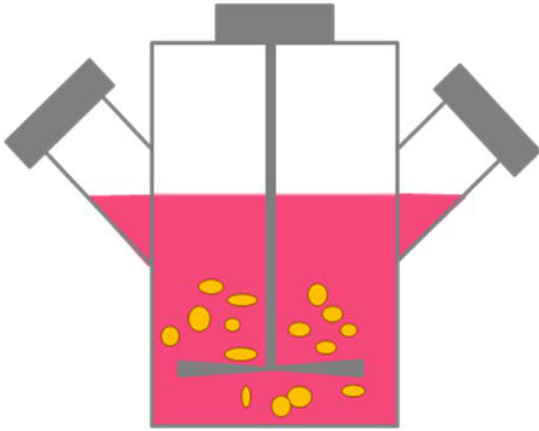
Figure 3. Cell culture in bottle with agitator. Cells start aggregating and self-assembling [9].